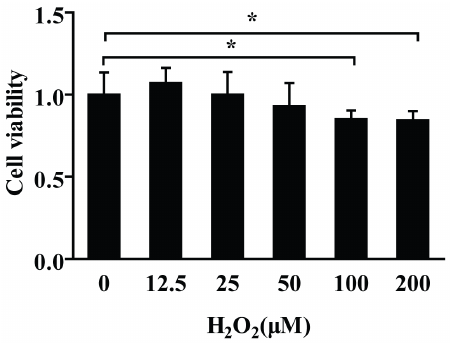
Figure 1. H 2 O 2 decreased PC12 cells viability. MTT assay showed that 12.5 , 25 m M H 2 O 2 treatment had no obvious effect, while 50 m M, 100 m M, and 200 m M H 2 O 2 treatment resulted in cell viability decrease by 7%, 15% and 16%, respectively. When compared with control group (0 m M), 100 m M and 200 m M group showed significant difference. Data are shown mean 6 SD (n=6). * P , 0.05, as compared with control.